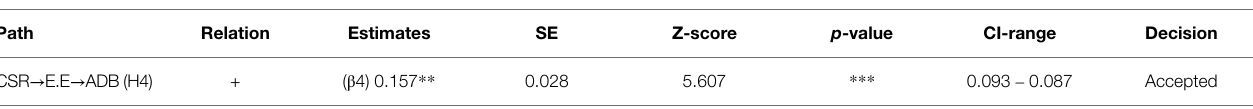
TABLE 8 | Mediation